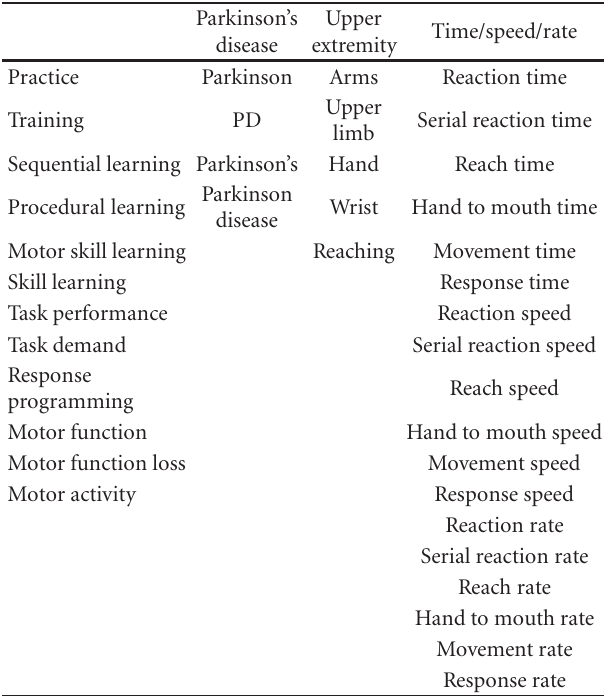
Table 1: Search terms used for the